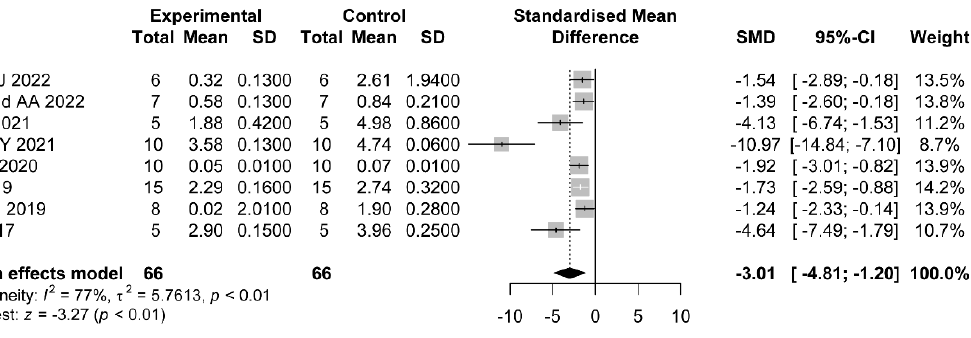
Figure 7. Forest plot of flavonoids for LH/FSH [30,32,35,38,39,43,45,46].